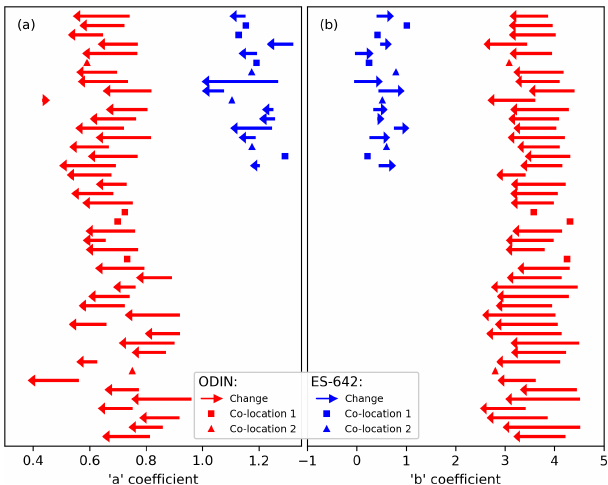
Figure 8. The change in the a and b coefficients used to generate version 1 of the data set. The fit coefficients are unitless. The ends of each arrow indicate the a and b coefficients calculated at co- location 1 (tail) and co-location 2 (head) for a single ODIN (red) or ES-642 (blue). In cases where an instrument was corrected against a single co-location, this value is plotted as a square (co-location 1) or triangle (co-location